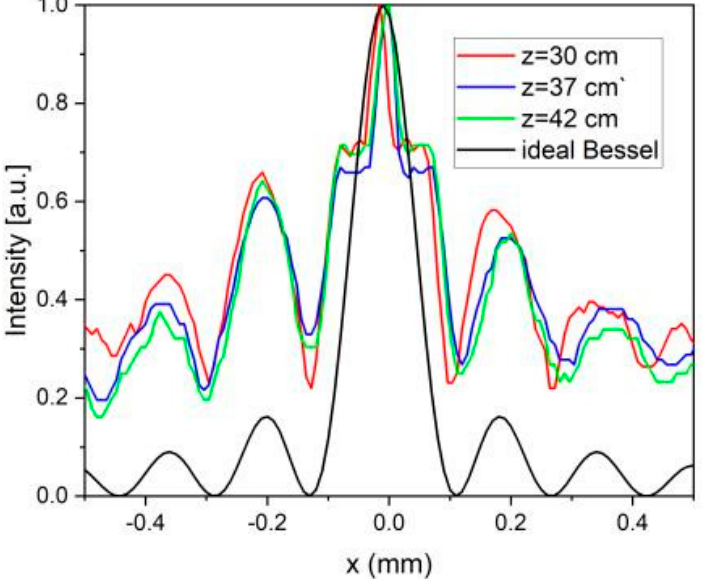
Figure 16. Intensity cross-sections of the zeroth Bessel-Gauss beams for z = 30 cm (red line), z = 37 cm (blue line), and z = 42 cm (green line). With the black line is represented the intensity of an ideal Bessel beam of order zero, |J 0 (k r x)| 2 .